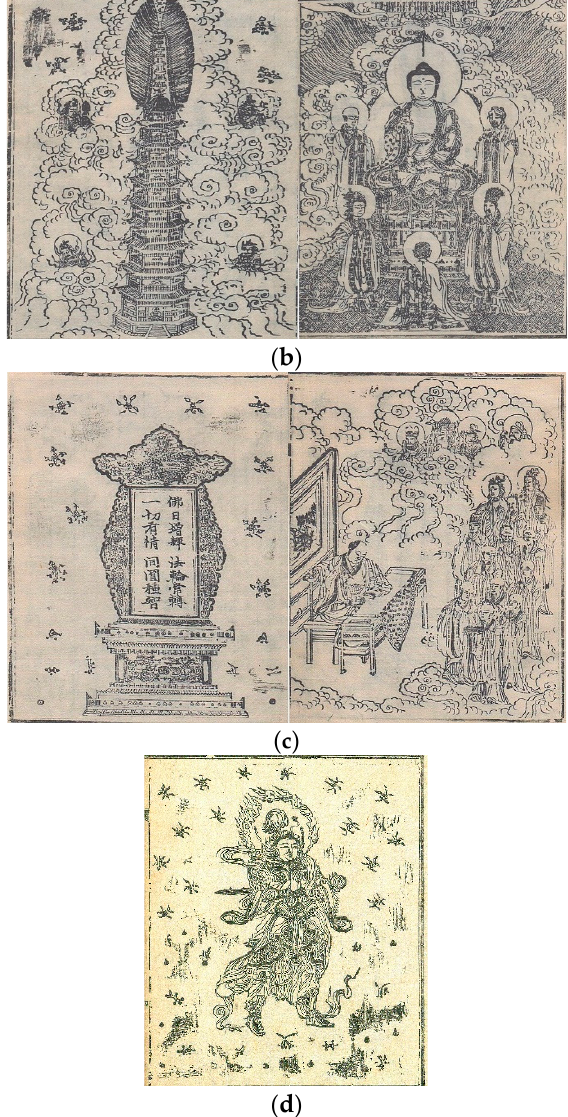
Figure 15. Lotus Sutra (Gongsanbonsa edition), published at Gongsanbonsa Temple, Joseon (1531), 25.5 × 21.0 cm, (( a ) first woodblock print; ( b ) second woodblock print; ( c ) third woodblock print; ( d ) fourth woodblock print), private collection. Photo by the author. Table 2. Joseon Lotus Sutra print editions featuring the Listener in monk form (before the mid- seventeenth century).